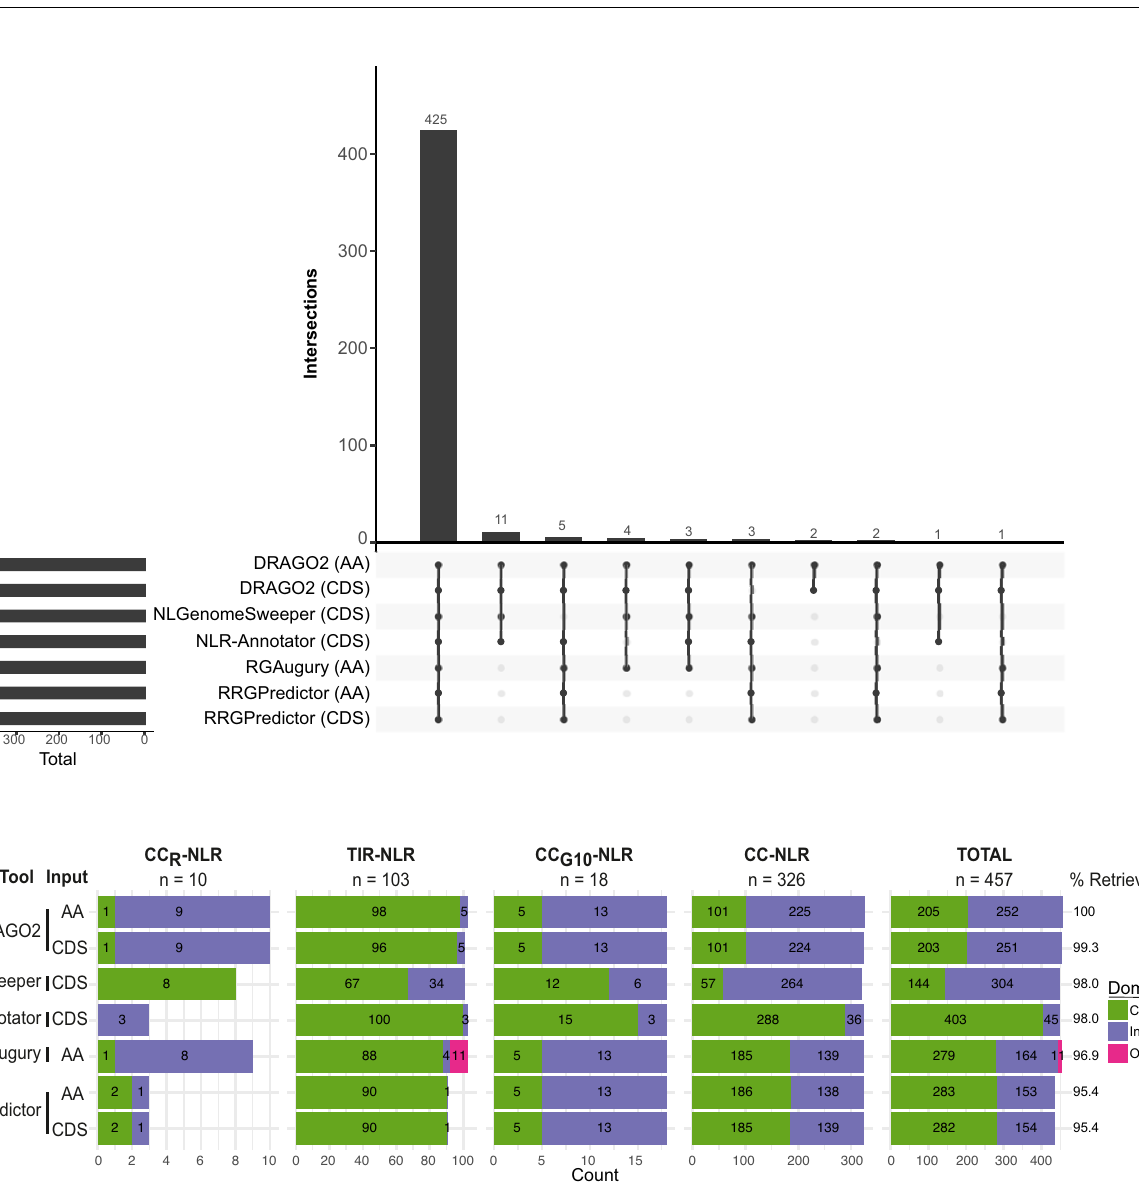
Fig 5. Benchmarking NLR annotation tools using RefPlantNLR. Benchmarking of NLR annotation tools using the RefPlantNLR dataset for which a CDS entry was available ( N = 457). ( A) UpSet plot showing intersection of RefPlantNLR entries retrieved by each annotation tool. ( B) Domain architecture analysis produced by each NLR annotation tool per NLR subclass. Correct domain architecture is consistent with RefPlantNLR annotation, incorrect is inconsistent with RefPlantNLR annotation. Other is retrieved by NLR annotation tool but not reliably classified as NLR. Underlying data and R code to reproduce the figures in S1 Appendix . CDS, coding sequence; NLR, nucleotide-binding leucine-rich